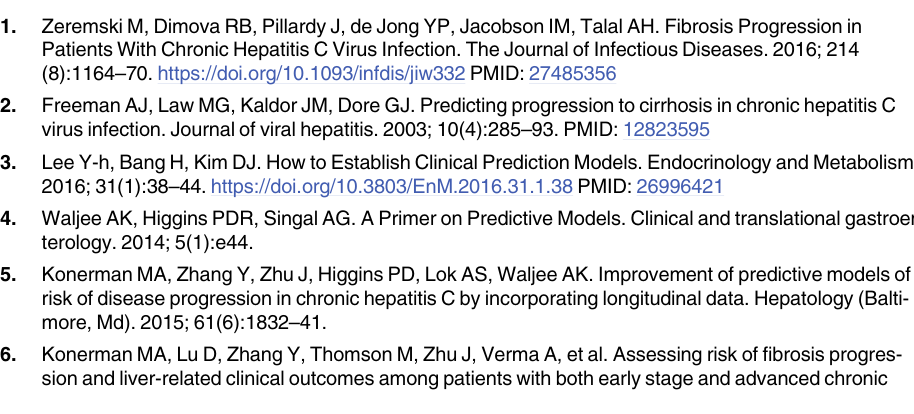
S1 Table. Variable selection frequency for cross-sectional Cox model. S2 Table. Variable selection frequency for longitudinal Cox